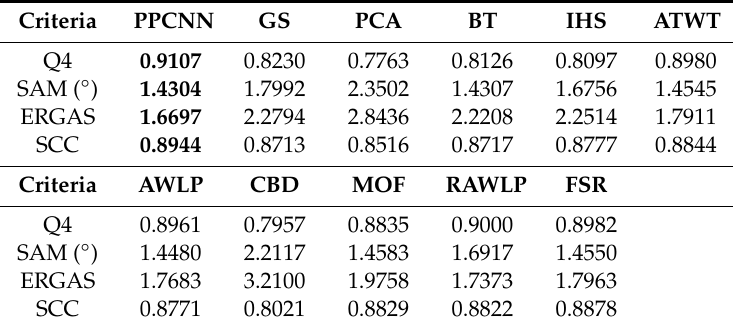
Table 5. Comparison results for Lanzhou